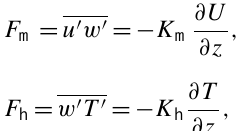
Fig. 4. Particle concentration data acquired with the gradient pole on 28 August over the snow surface: (a) measurement height [cm], (b) particle concentration [cm − 3 ], (c) normalized particle concen- tration [cm − 3 ]. A total of 7 scans began at 14:20 (initial data not shown), with an average sampling time per height level=20s. Av- erage data points per height